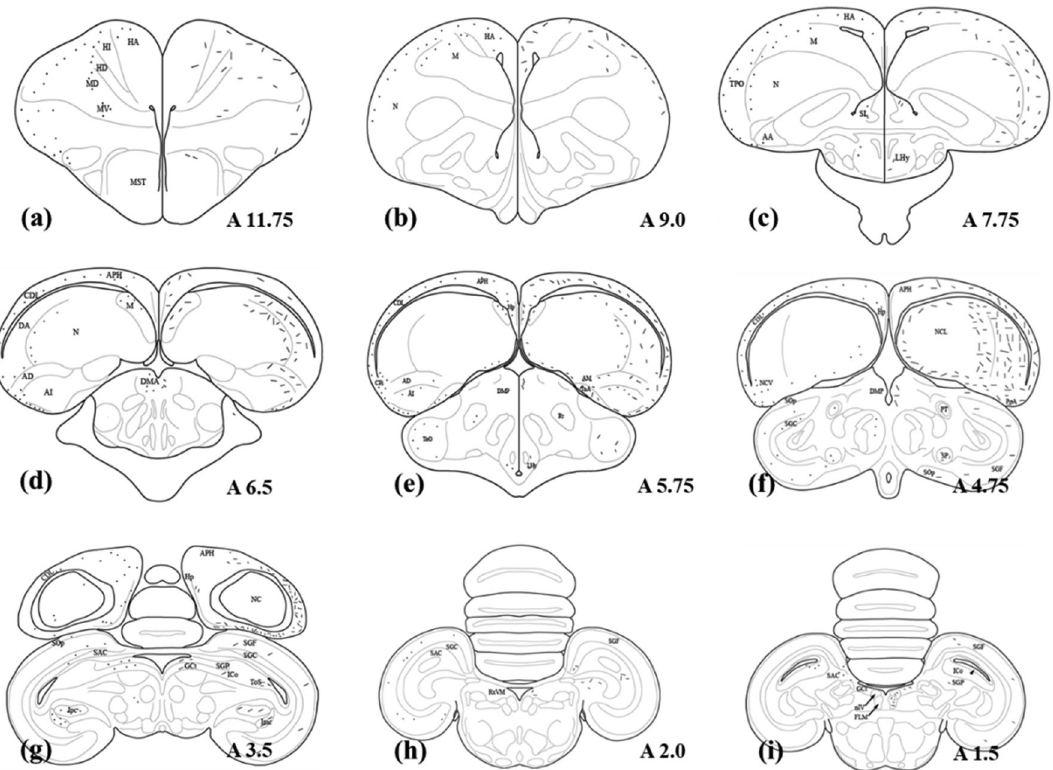
Figure 2. Schematic illustration of the rostrocaudal extent of labeling after BDA or CTB injections into the PoAb. Dots represent neurons retrogradely labeled with CTB on the left side, short lines represent anterogradely labeled terminals on the right side. Dots and lines indicate the relative differences in distribution but do not represent actual numbers. BDA biotinylated dextran amine; CTB cholera toxin subunit B; PoAb basal division of posterior pallial